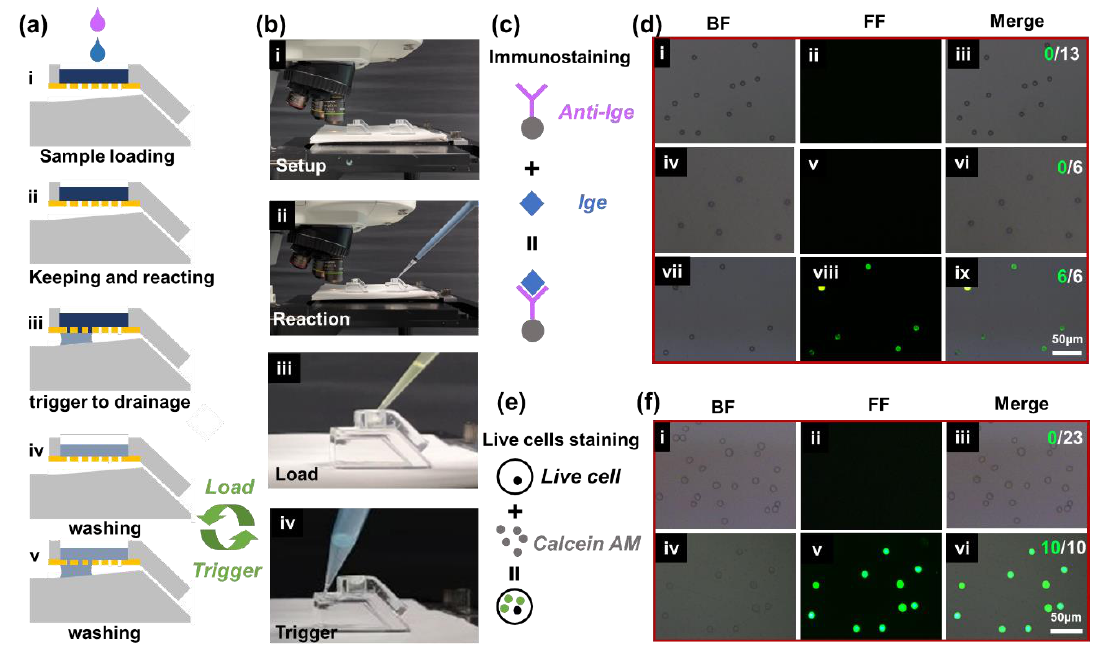
Figure 7. The results of biochemical reactions with multi-step operations. ( a ) The procedure of multi- step chain biochemical reactions. ( b ) Experimental equipment and operation flow chart. ( c ) The principle of immunostaining. ( d ) Staining reaction results of immunostaining. ( e ) The principle of live cell staining. ( f ) Staining reaction results of live cells.